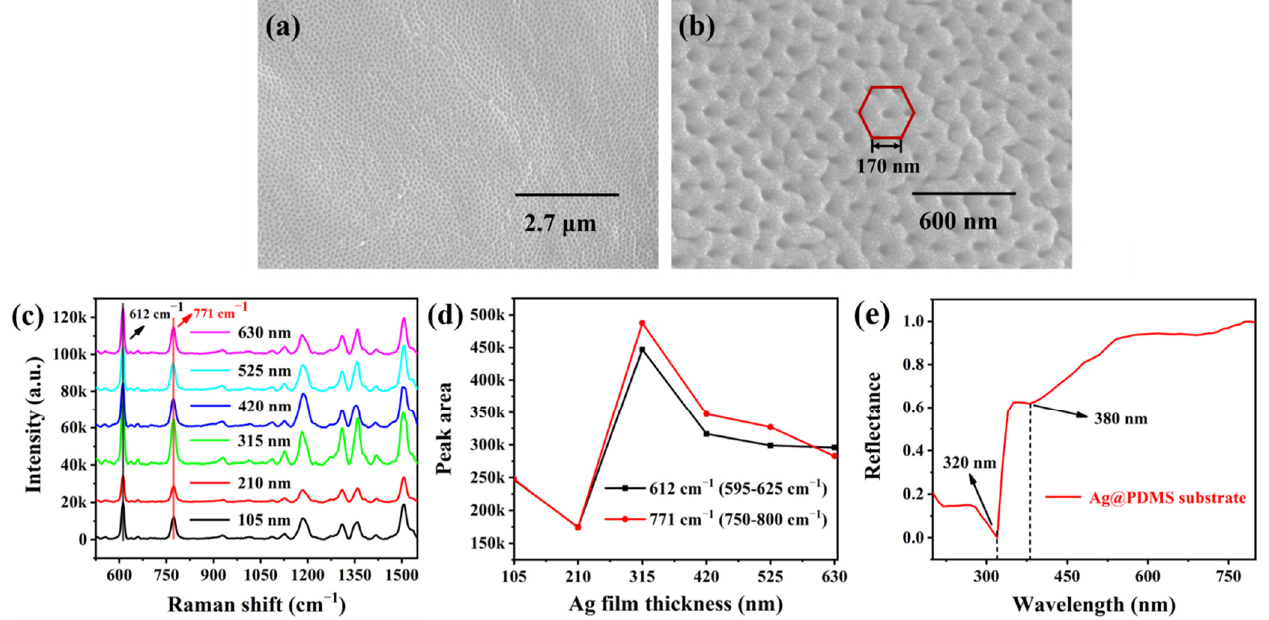
Figure 2. Ag@PDMS substrate characterization and optimization. SEM images of Ag@PDMS substrate with Ag film thickness of 210 nm at the ( a ) micro and ( b ) nano levels. ( c ) The SERS spectra of 10 − 6 M R6G adsorbed on different Ag@PDMS substrates, and ( d ) the variation trend of integrated intensities at 612 cm − 1 (595 − 625 cm − 1 ) and 771 cm − 1 (750 − 800 cm − 1 ) peaks. ( e ) Reflectance spectra of Ag (315) @PDMS substrate.